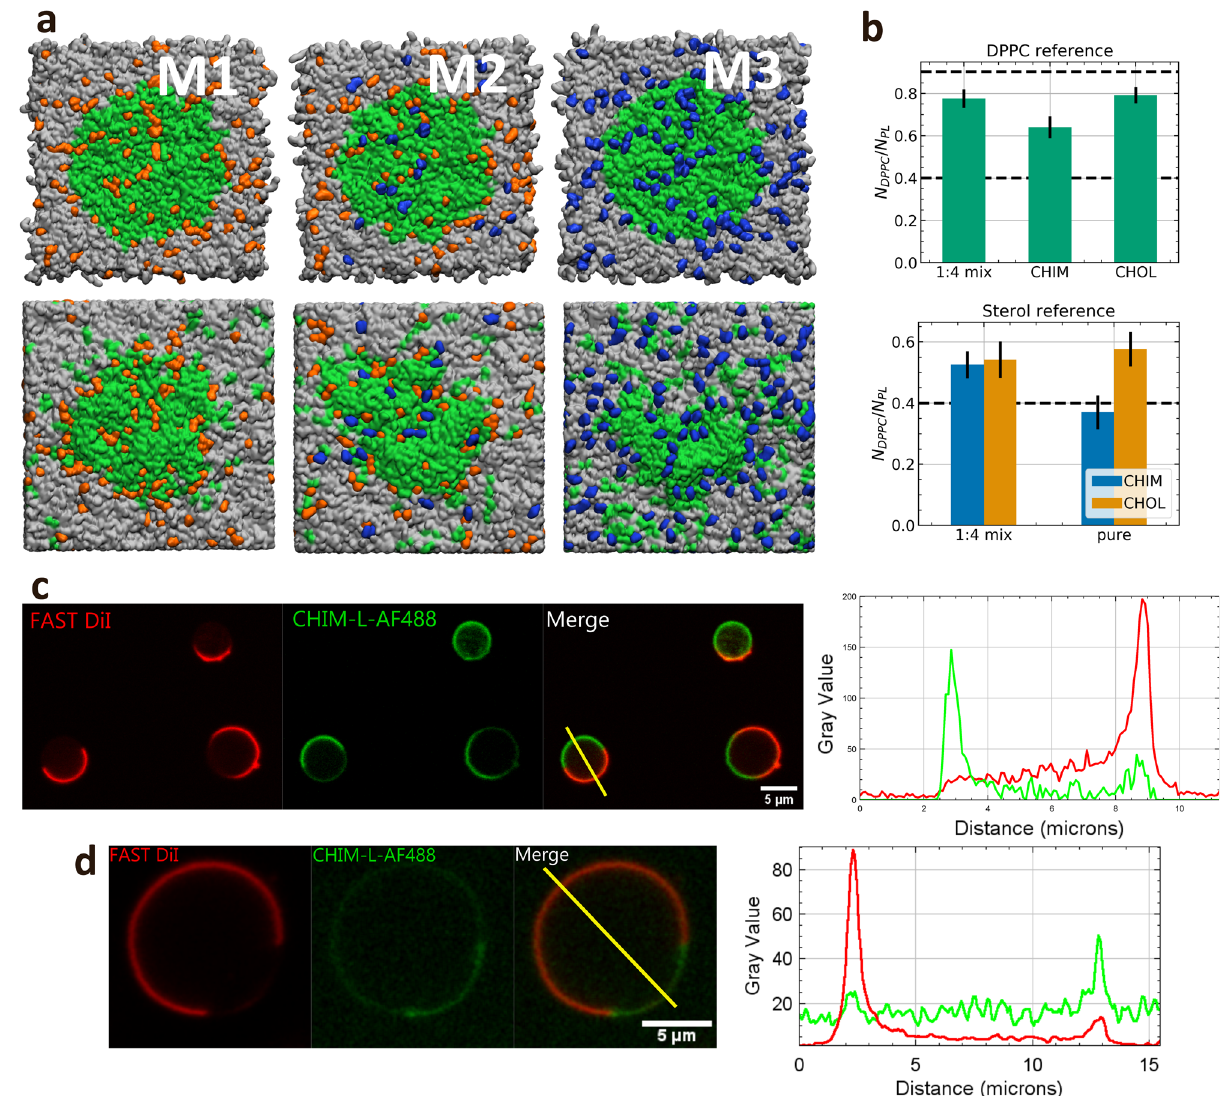
gray, CHOL in orange, and CHIM in blue. The top row shows snapshots of the initial con fi guration while the bottom row shows snapshots of the fi nal con fi guration after a simulation of at least 3 µ s. b Top: Average ratio of DPPC neighbors over the total number of PL neighbors around DPPC averaged over the last 25% of the simulation. Bottom: Average ratio of DPPC neighbors over total PL neighbors around CHOL or CHIM. The dashed lines at 0.9 indicate complete segregation and at 0.4 complete mixing. c GUVs composed of POPS:DLiPC:DPPC:CHIM-L (14.29:42.85:28.57:14.29), stained with FAST DiI and clicked with AF488. Lipid segregation occurs at RT, as revealed by FAST DiI labeling of the Ld phase. Note that CHIM-L (labeled by the click reaction with AF488) shows a tendency to partition into Lo, as also seen in the line plot on the right. d DCA-treated GPMVs derived from HUVEC labeled with FAST DiI and fl uorescently labeled CHIM-L (AF488). Note that CHIM partitions into the more ordered phase (Lo) negative for FAST DiI. The corresponding line plot ( fl uorescence intensity) for the vesicle is displayed on the